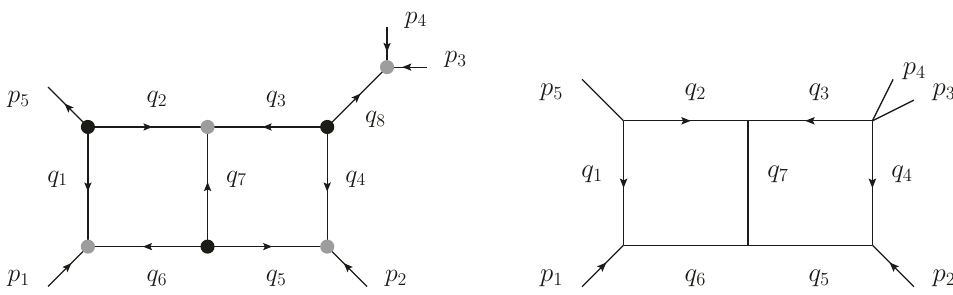
Figure 8 . Left: two-loop NMHV 5 on-shell supergraph of the double-box topology contributing to (cid:22)(cid:8)(1)(cid:22)(cid:8)(2)(cid:22)(cid:8)(3)(cid:22)(cid:8)(4)(cid:9)(5) the amplitude . Right: the corresponding bosonic integral h i the double-box topology with one massive